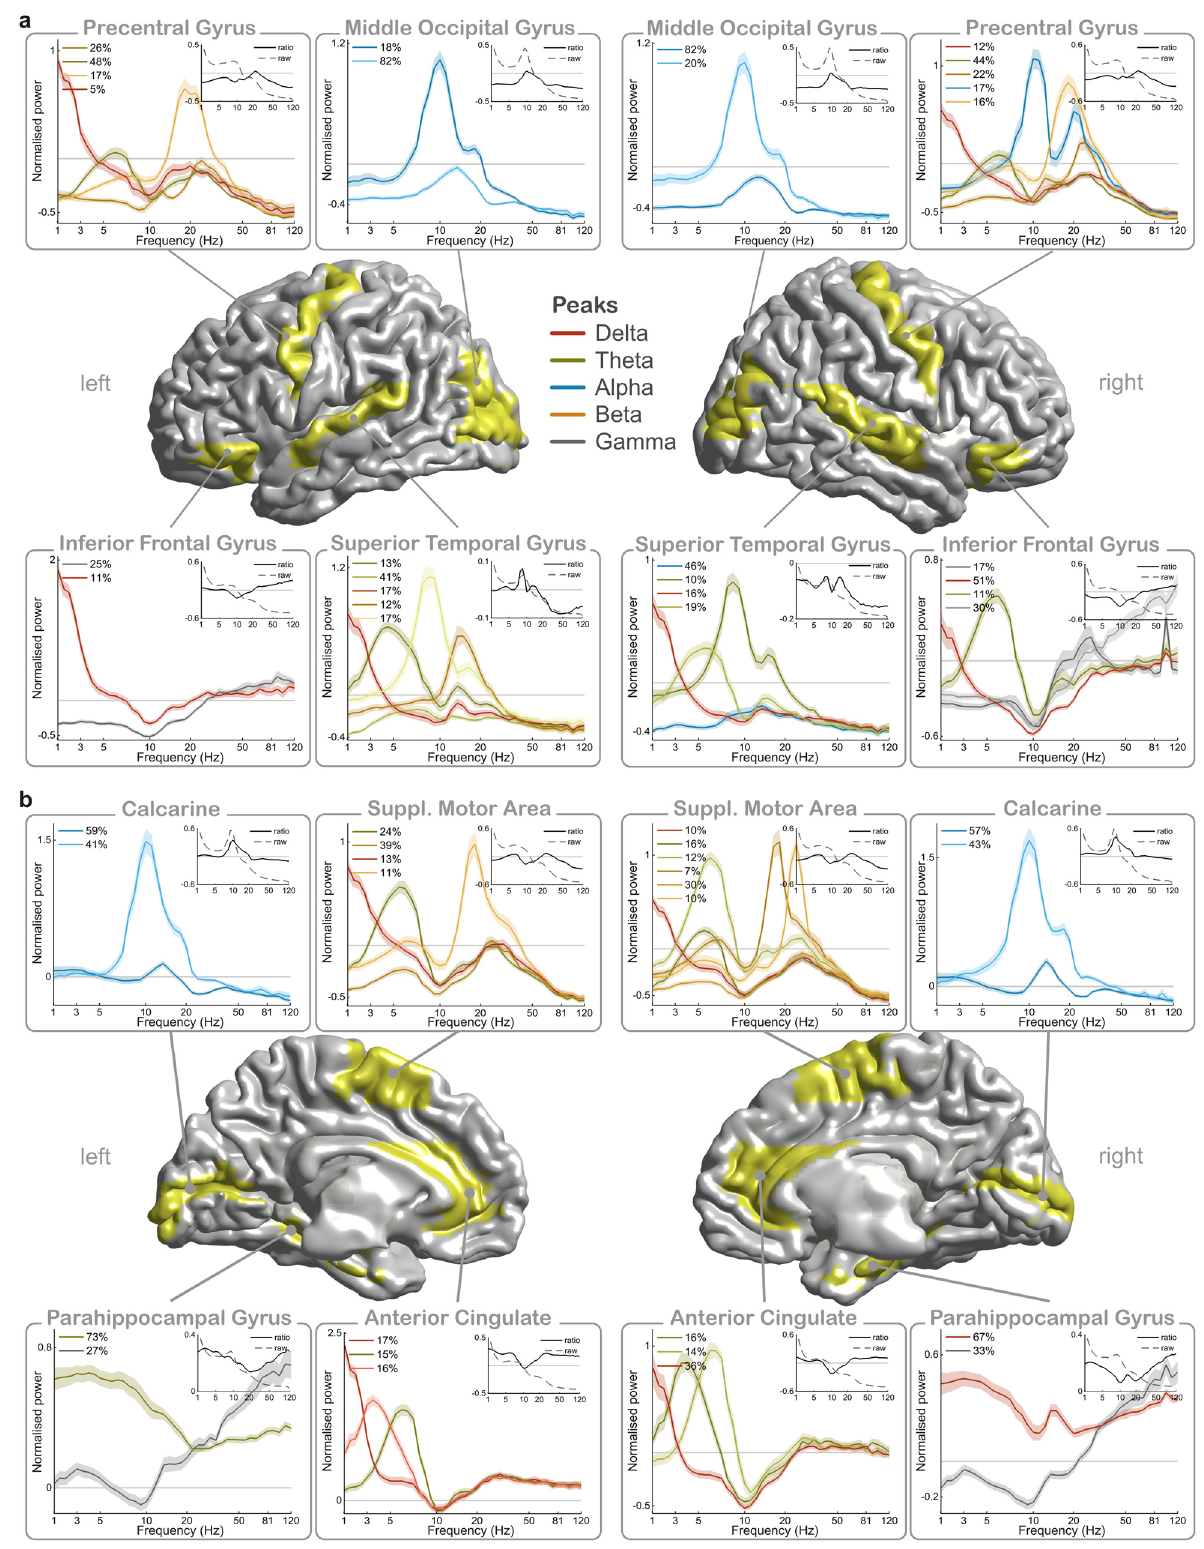
Fig 2. Spectral profiles of 16 example areas seen a) laterally and b) from the midsagittal plane. Clustered power spectra in source space represent normalised power, i.e., spectral power in comparison to the whole brain. Legends show the corresponding duration of each pattern (i.e., the percentage of trials in which each spectrum was present on average during recording). Shaded error bars illustrate the standard error of the mean across participants. The lines are colour-coded for the respective frequency bands (red: delta, green: theta, blue: alpha, orange: beta, grey: gamma). Inlets show average power spectra for respective areas without normalisation (dotted PLOS Biology | DOI:10.1371/journal.pbio.1002498 June 29,